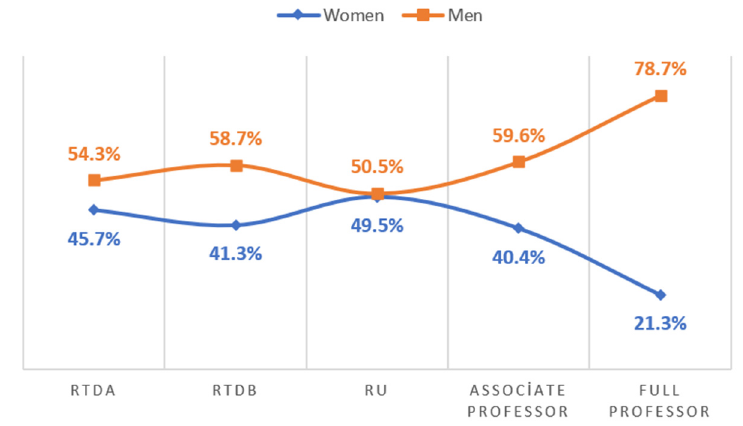
Figure 1. Gender distribution of academic roles in Italy in 2020.